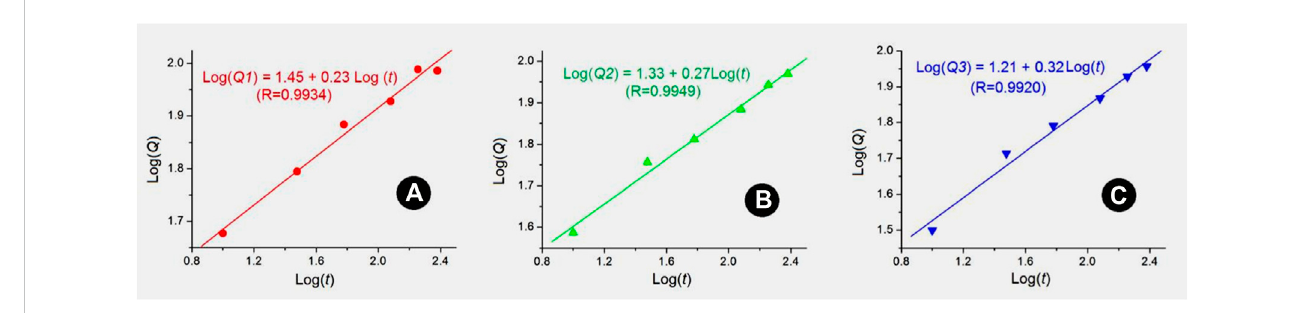
FIGURE 9 Drug release mechanisms based on Peppas equation: (A) S1; (B) S2; (C) S3.